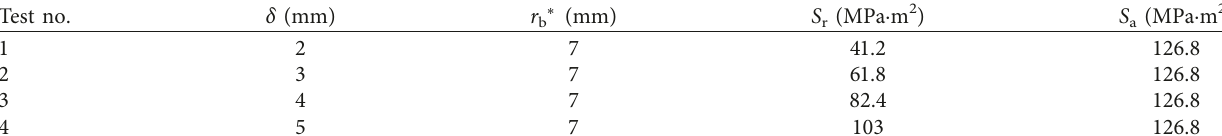
Table 1: Constraint stiffness in the four